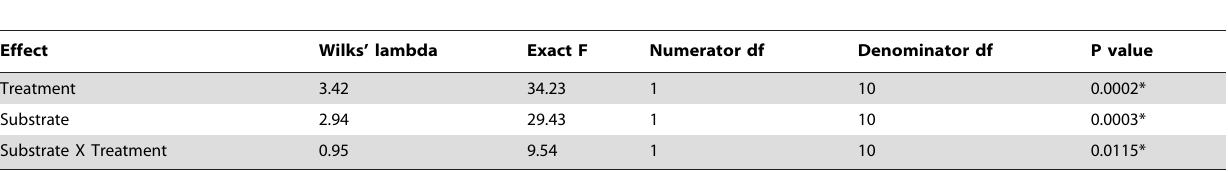
Table 1. Repeated measures MANOVA shows a significant difference in time to regain maximum shear adhesion based on substrate (glass or PMMA), treatment (stepping or no stepping) and their